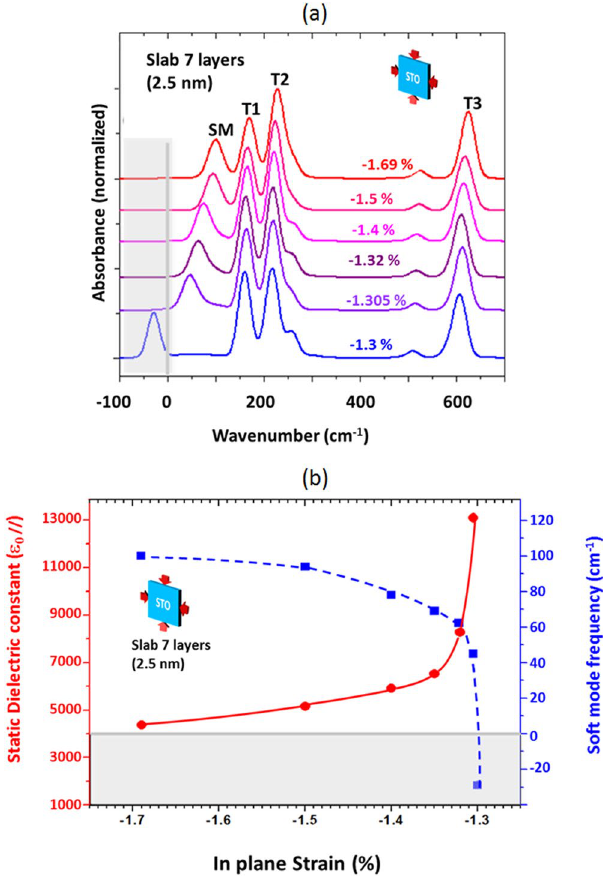
Figure 2. Results of DFT calculations for a STO slab of 7 layers under various in-plane strains between − 1.69% and − 1.30%. ( a ) Simulated spectra for various strains. A very strong dependence of the Surface/Soft mode (SM) passing from ~100 cm − 1 to an imaginary value as the strain decreases is observed. At − 1.305% strain, the SM is located at 40 cm − 1 while it becomes imaginary for strain of − 1.3%. ( b ) Variations of the Soft Mode frequency and of the static dielectric constant parallel to the slab as a function of the strain. The values of both the soft mode and the in-plane static dielectric constant diverges for strain values under −